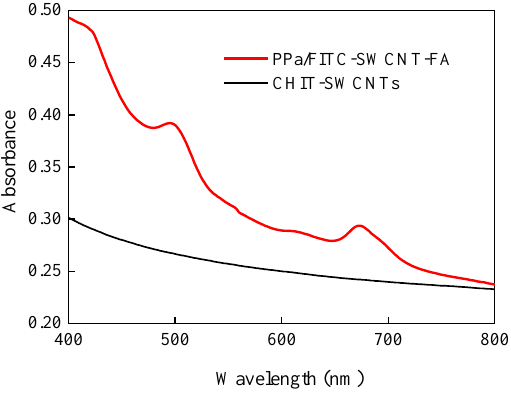
Figure 2. A typical transmission electron microscope image of SWCNTs and a photography of SWCNTs solution (inset).